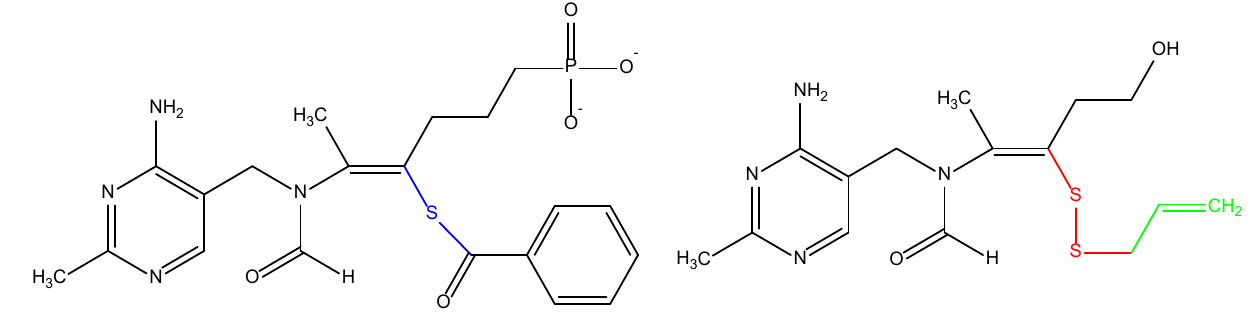
Figure 5. Structure of benfothiamine ( left ) and allithiamine ( right ).